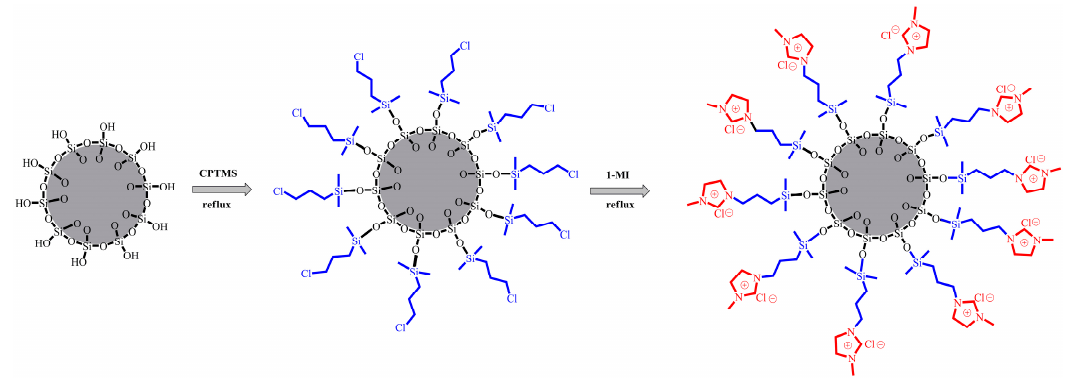
Figure 1. Scheme of supported ionic liquid silica (IL-silica). CPTMS: 3-chloropropyltrimethoxysilane; 1-MI: 1-methylimidazole. 1-MI: